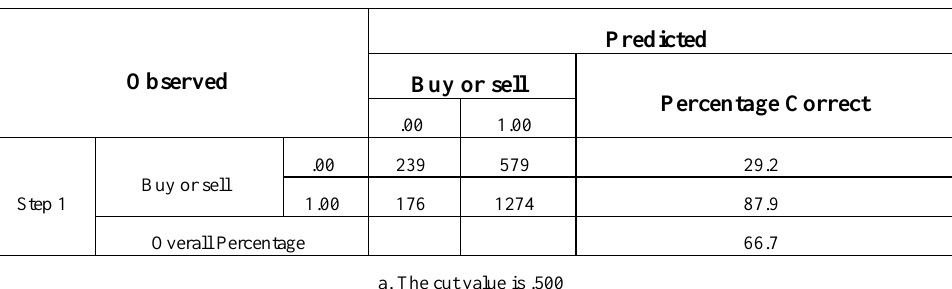
Table 2. Classification of